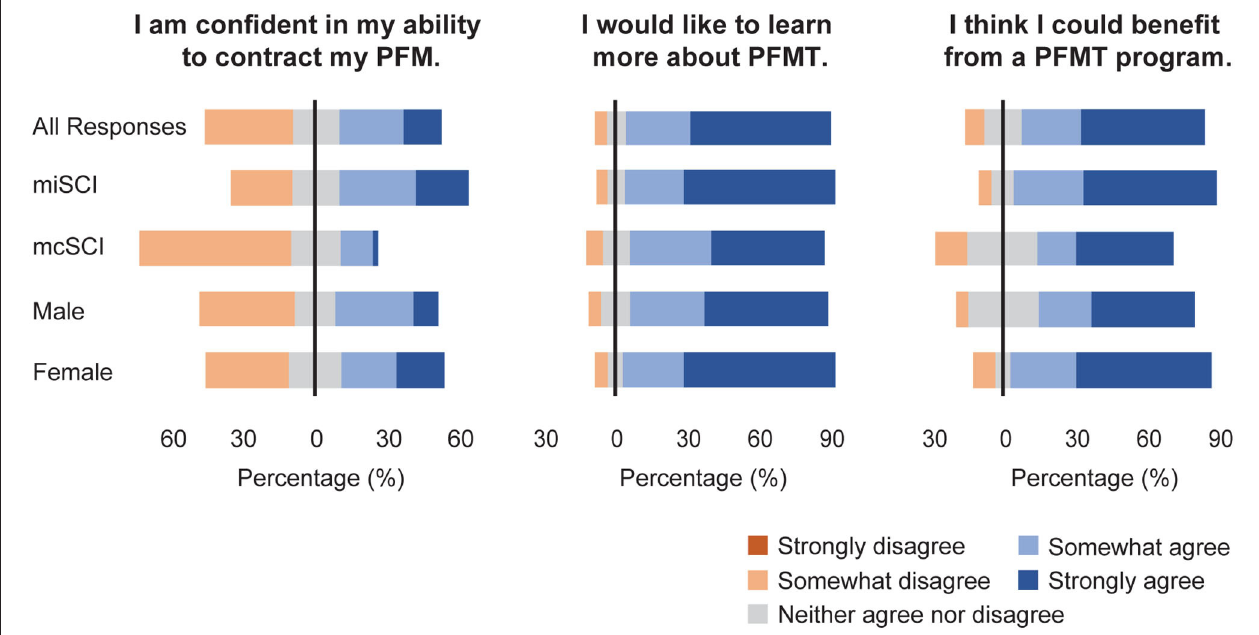
FIGURE 3 | Attitudes to PFMT, reported for the complete sample and grouped by motor function and sex.